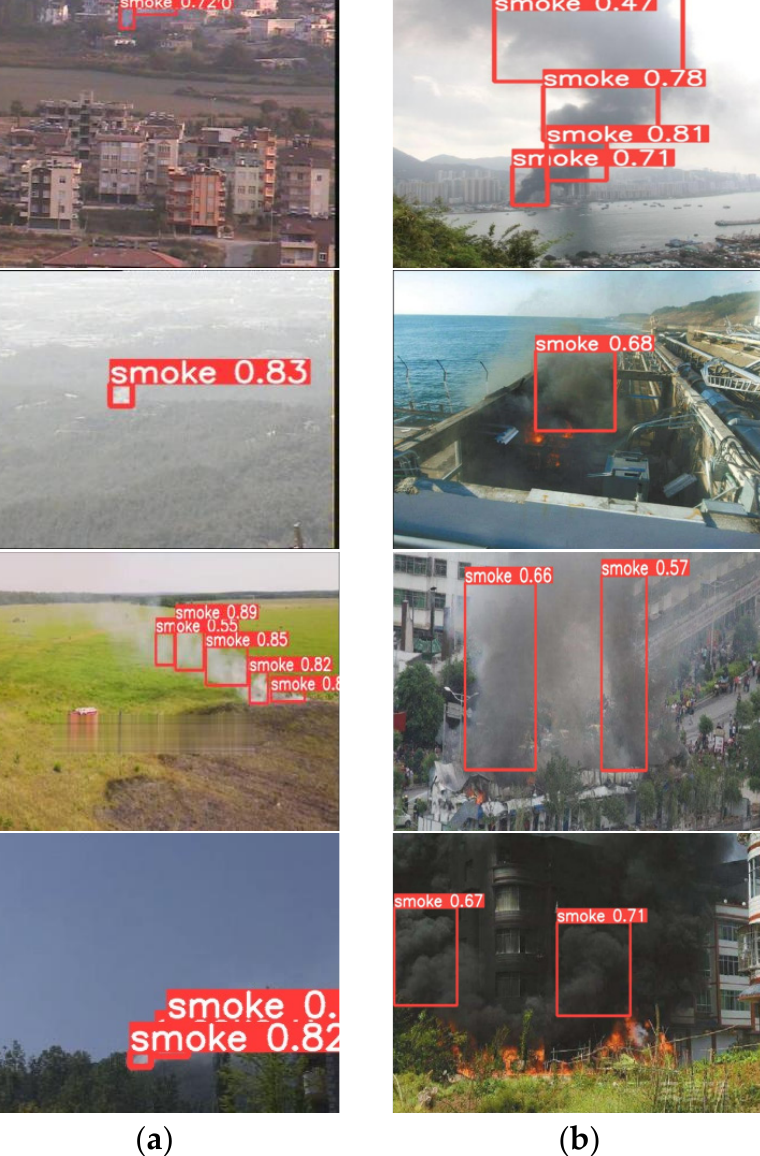
Figure 5. The detection results of challenging smoke images. ( a ): small smoke, ( b ): black and brown smoke.